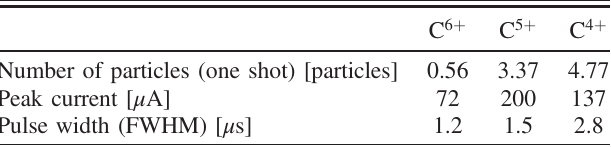
TABLE I. Parameters of carbon ions.